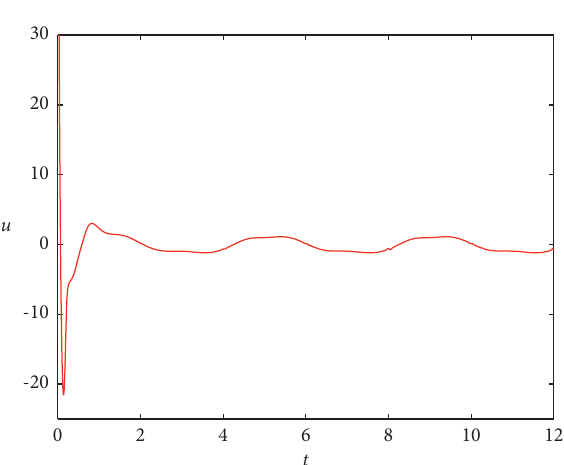
Figure 12: Control input u for Example